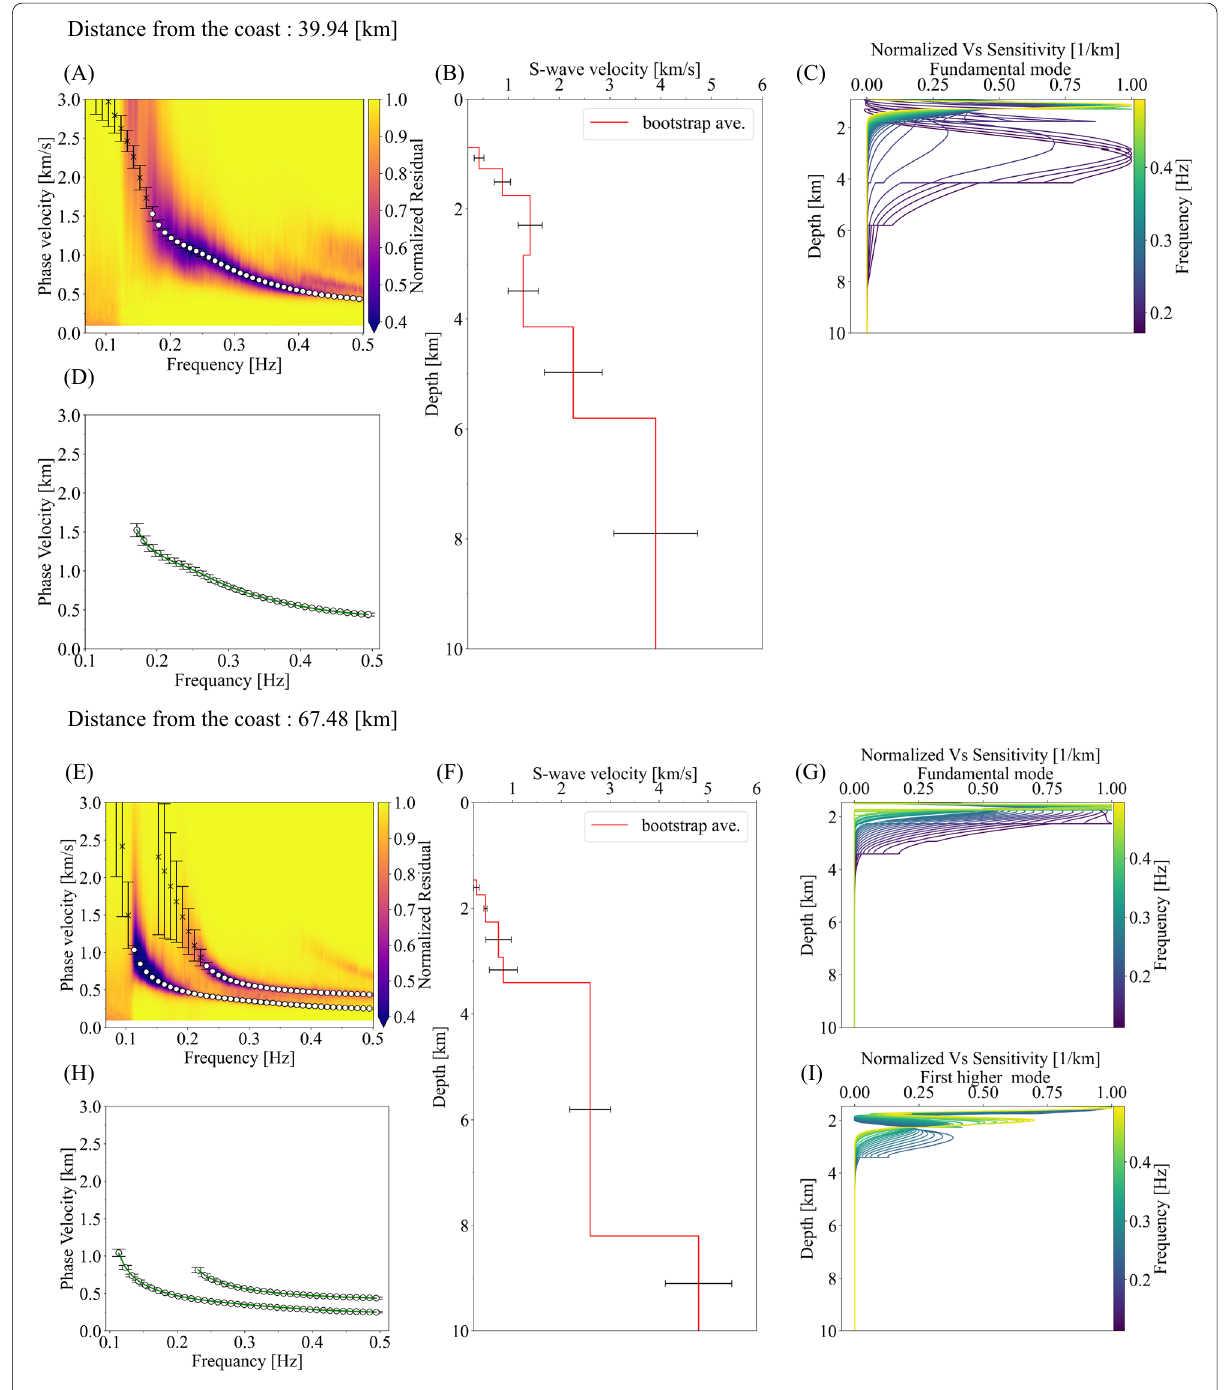
Fig. 3 Phase velocity, V s structures, and sensitivity kernel. A and E —Normalize residuals and estimation phase velocity at subarrays from the coast of 39.94 and 67.68 km, respectively. The error bars represent the uncertainties estimated by the bootstrap method. The white dots and cross makers indicate errors less than and more than 0.1 km/s, respectively. We used phase velocity only with an error less than 0.1 km/s for our inversion analysis. B and F — V s structures at subarrays from the coast of 39.94 and 67.68 km. D and H White dots and green lines indicate the observed and estimated phase velocities, respectively. The errors were estimated by the bootstrap method. C Normalized V s sensitivity kernel of the fundamental Rayleigh wave at 39.94 km from the coast. G and I Normalized V s sensitivity kernels of fundamental and first higher mode Rayleigh waves at 67.68 km from the